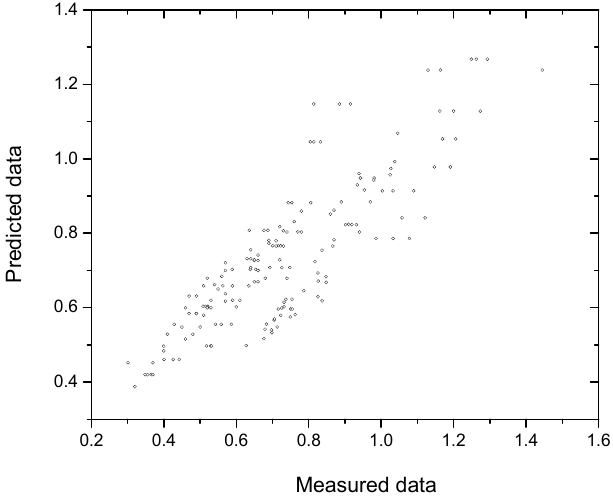
Figure 5. Thermal conductivity of predictive and measured values.